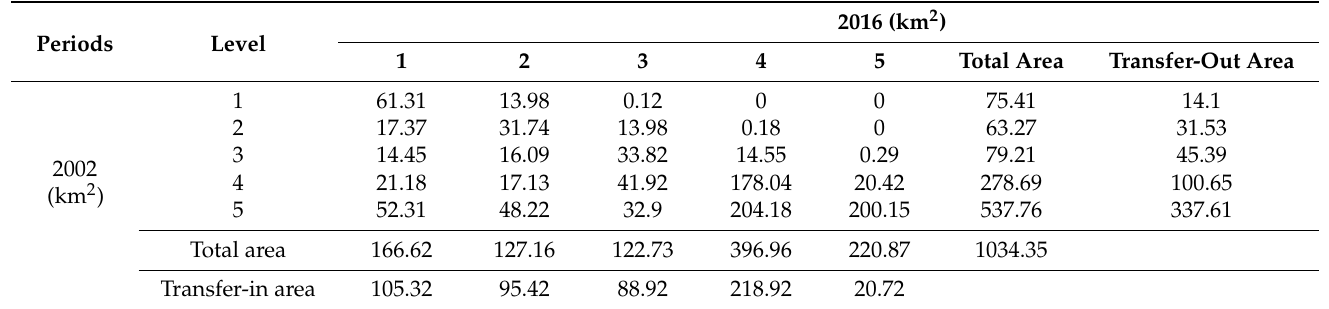
Table 3. Conversion matrix of different vegetation coverage levels in 2002 and